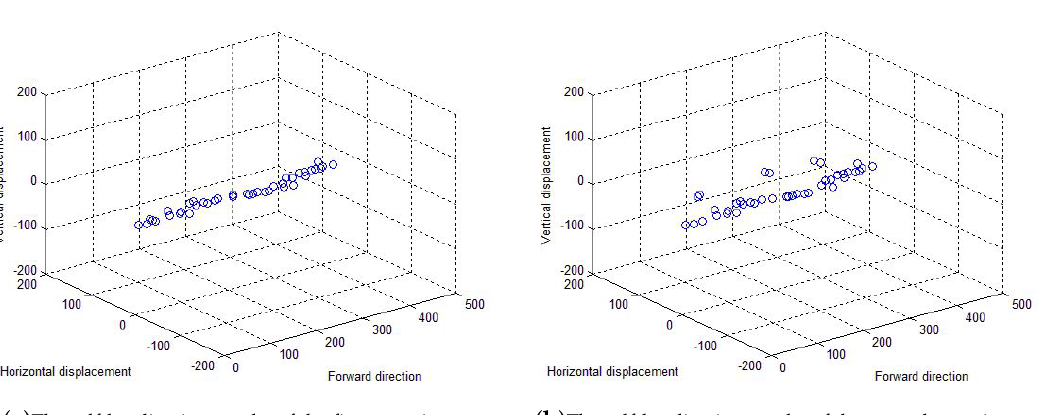
Figure 13. The localization results of the experiments. The mobile robot moved on smooth and non-smooth ground for the first and second experiments, respectively. The blue dot represents the localization of the mobile robot in the environment. It consists of the forward, horizontal and vertical